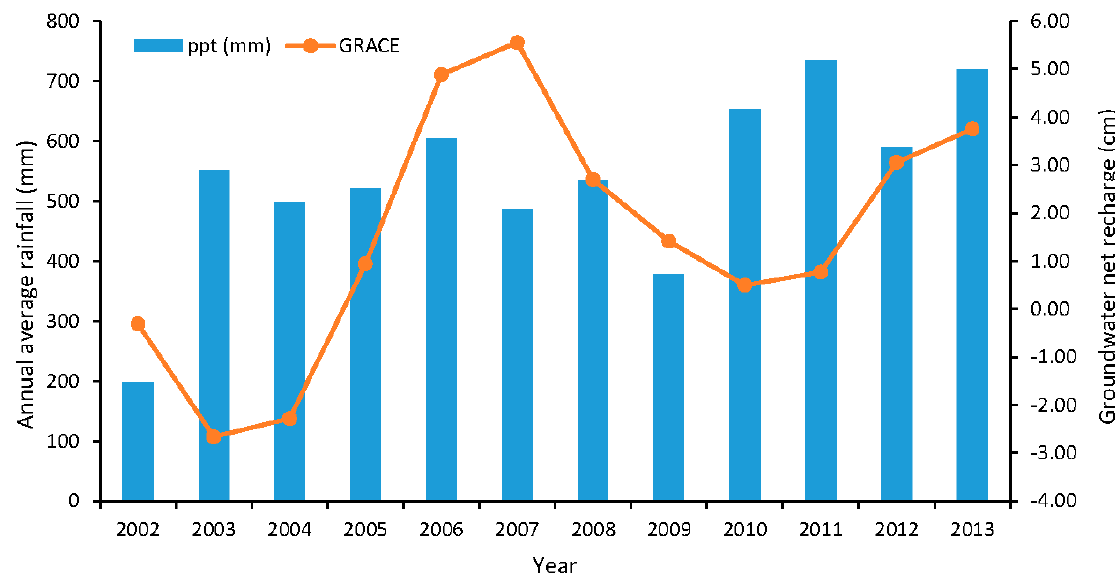
Figure 7. Comparison between annual average rainfall and GRACE net estimated groundwater recharge.